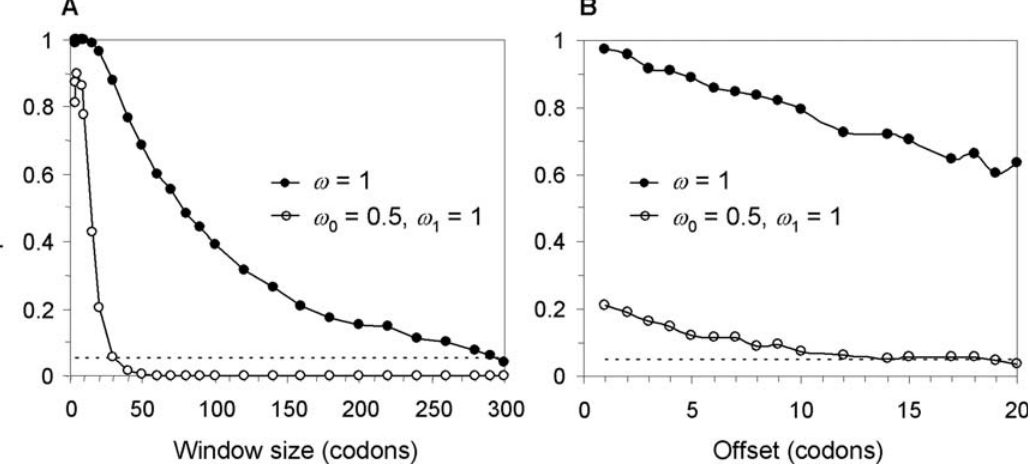
Figure 3. The overall false-positive rate of the sliding-window test of positive selection plotted against the window size. Data of a pair of sequences are simulated under either model M0 (one-ratio) with v =1 ( N ) or model M1a (neutral) with two site classes in proportions p 0 = p 1 = K with v 0 =0 and v 1 =1 ( # ). An LRT is used to test for positive selection in each window, by fitting model M0 (one-ratio) to the data, either with v $ 1 estimated or with v =1 fixed, and by comparing twice the log likelihood difference between the two hypotheses with 2.71, at the 5% level. If the test is significant in any window, positive selection is claimed to be detected for the replicate data set. The false-positive rate is calculated as the proportion of replicate datasets in which the test is significant in at least one window. The sequence length is 300 codons. The impact of the window size is examined in A , with the offset fixed at one codon, while the impact of the offset is examined in B , with the window size fixed at 20.